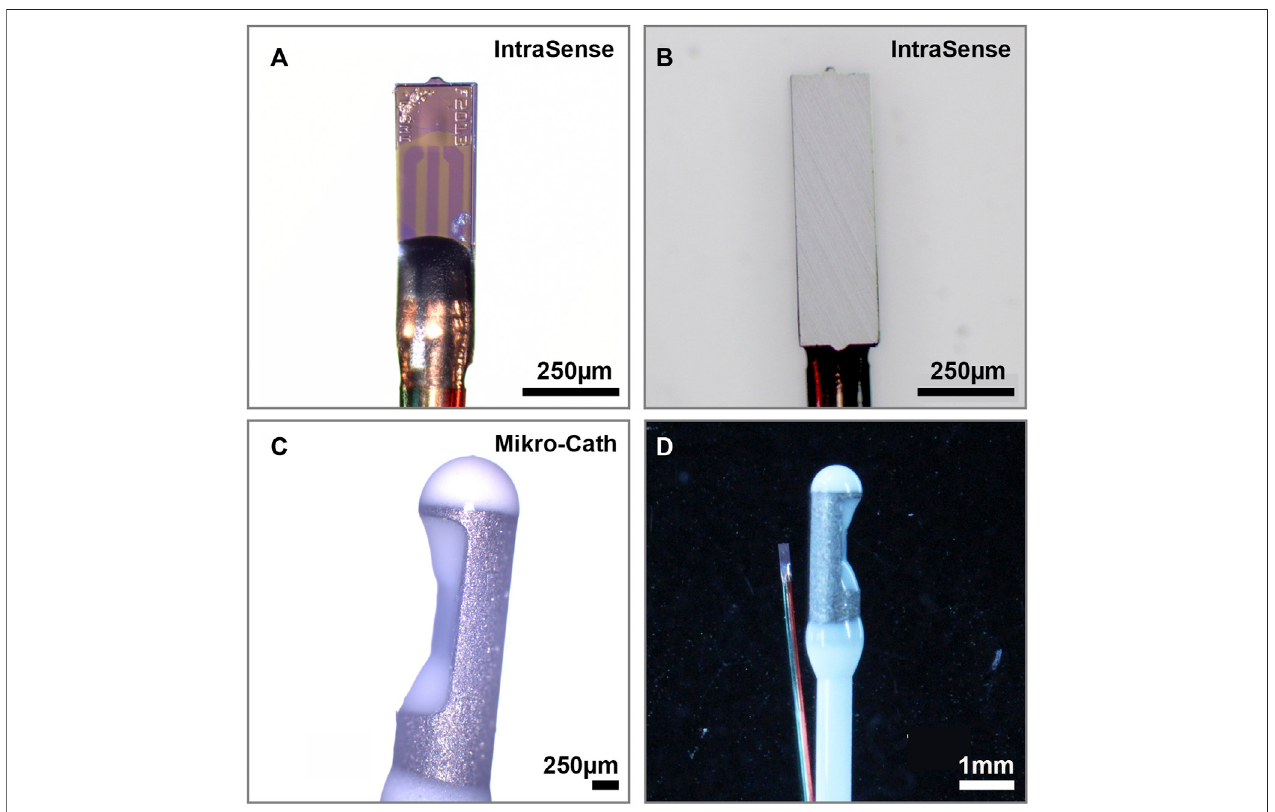
FIGURE2| PressureSensors (A) SMi ’ sIntraSenseisadisposablepiezoresistiveabsolutepressuresensorwithapressuresensitivemembraneclosetothetipand a (B) metal undersurface (750 × 220 × 75 µm) that can be integrated into a 0.33 mm hypo tube (C) Millar ’ s Mikro-Cath is a CE certi fi ed, and FDA approved disposable piezoresistive relative pressure sensor with a pressure sensitive membrane integrated into an indentation just below the catheter tip (D) Side to side comparison reveals the size differences between both sensor